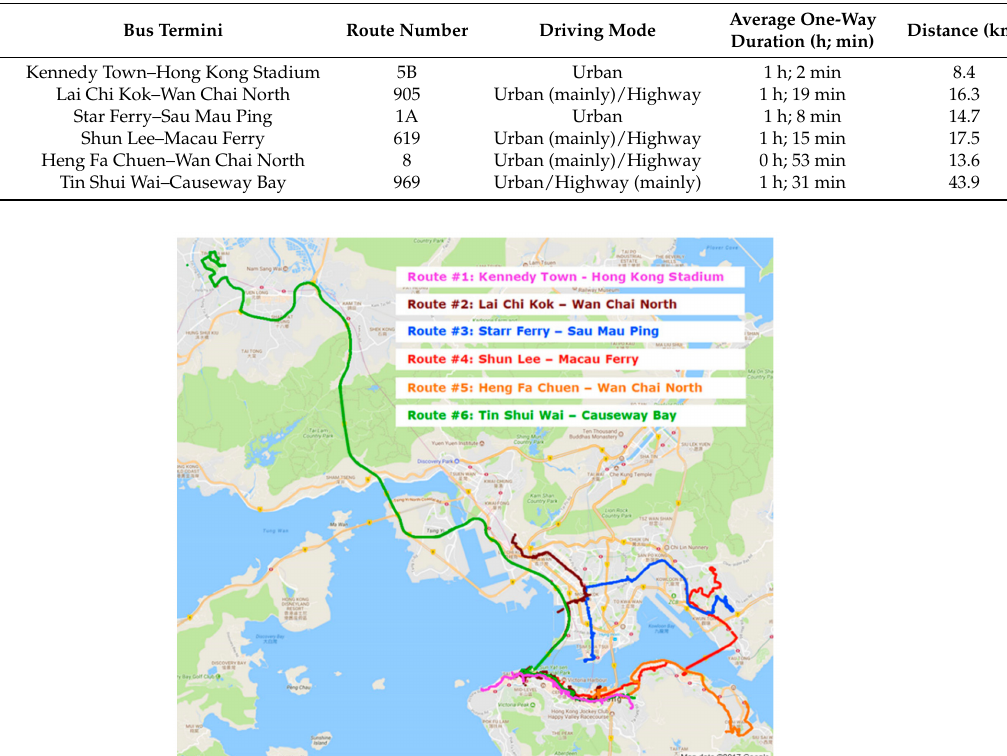
Table 2. Overview of the testing routes; each one was executed at least three times in both directions.